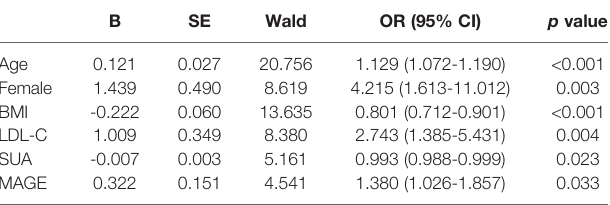
TABLE 3 | Multivariate logistic regression analysis to determine independent factors associated with osteoporosis susceptibility in T2DM patients. B